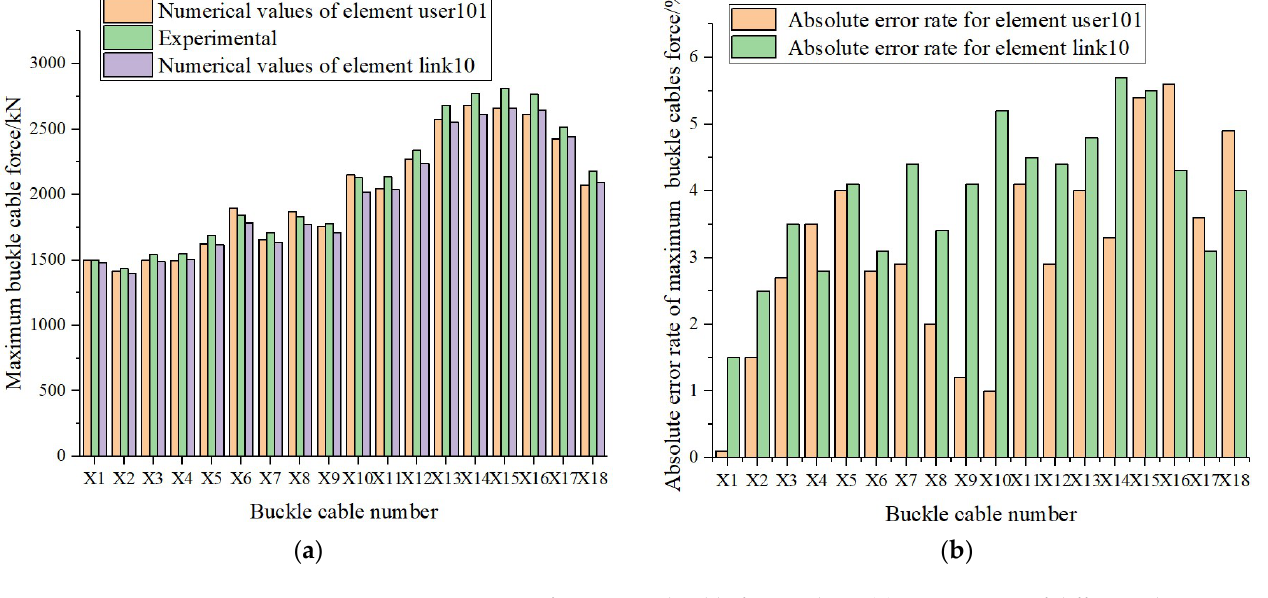
* Numbers in parentheses indicate the absolute error percentage with respect to experimental results.